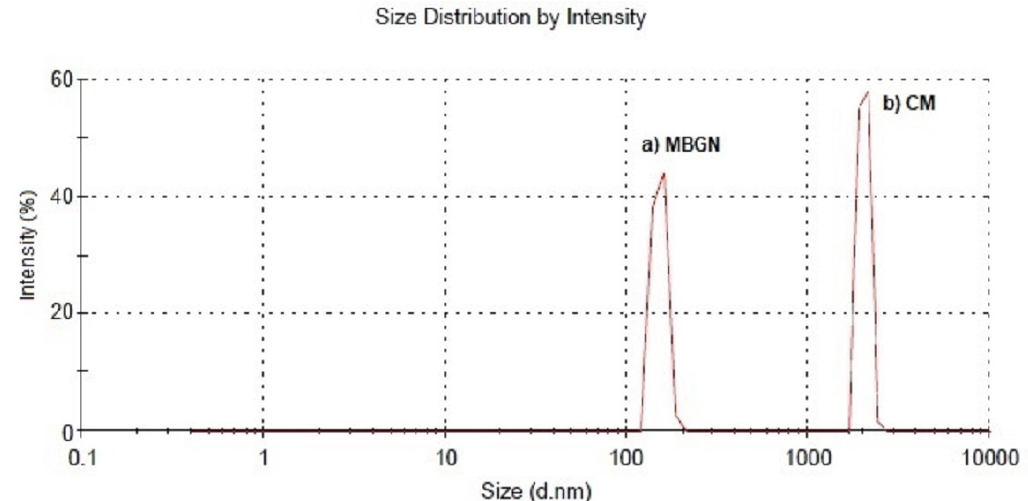
Figure 1. Average particle size distribution of ( a ) MBGN and ( b ) composite microspheres (CM) measured by laser diffraction.